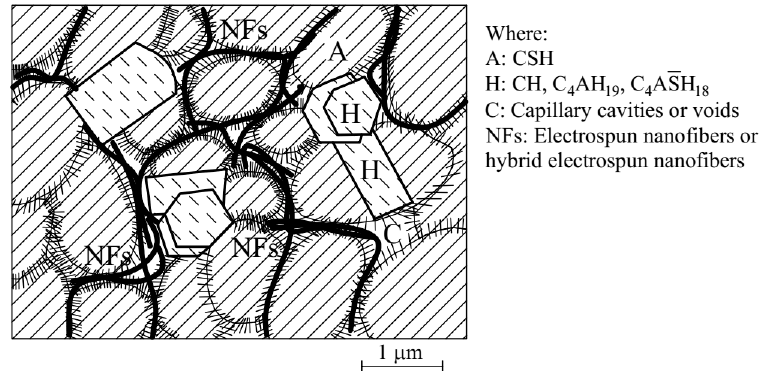
Figure 5. The bridging and filling mechanism of electrospun nanofibers in the hydrated cement paste.